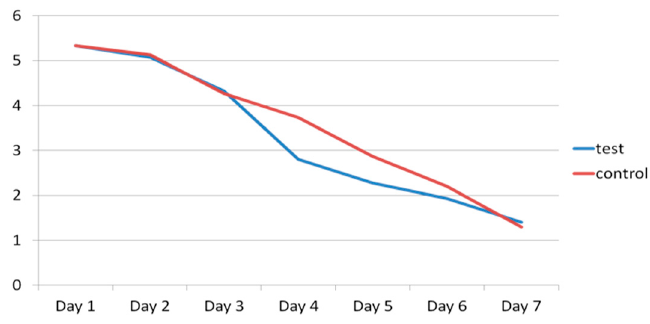
Figure 16. Evolution of pain in test group (blue) and control group (red) for seven days after surgery.